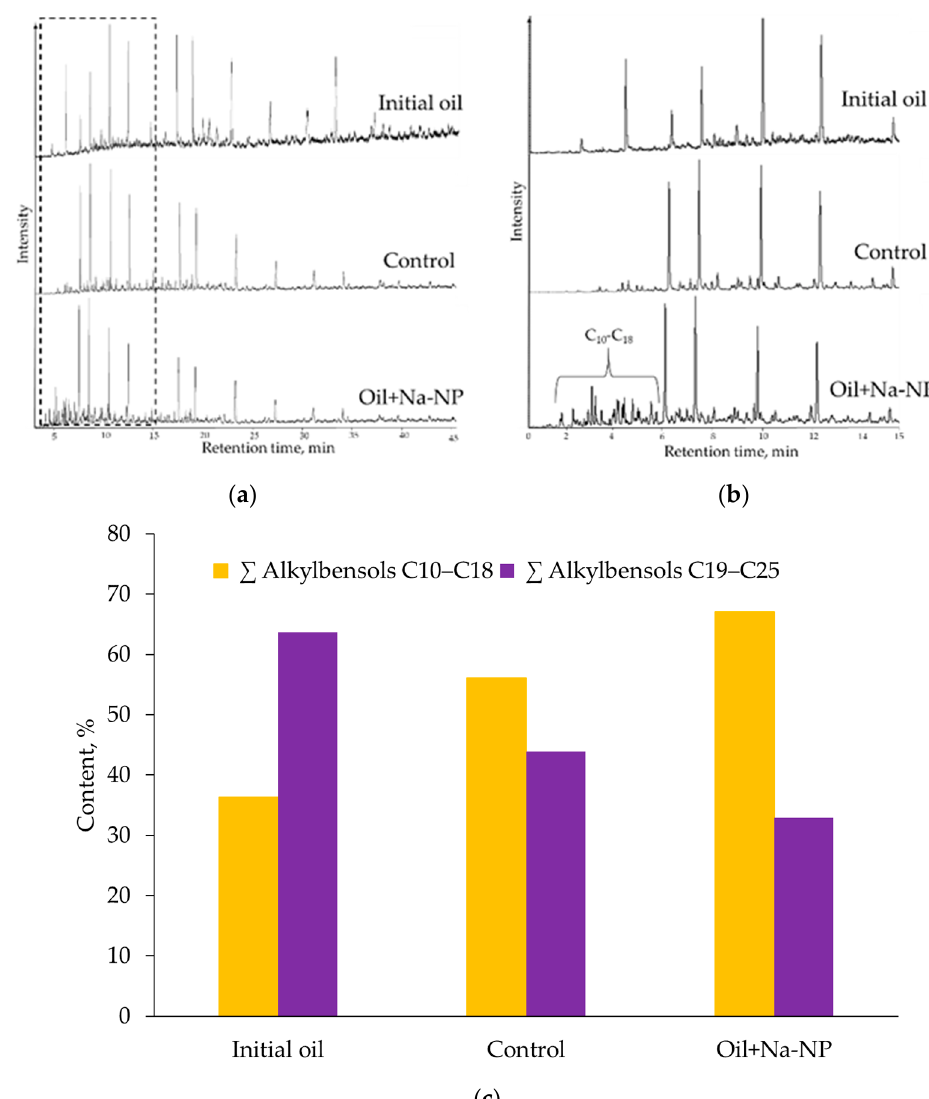
Figure 7. GC-MS spectra of ( a ) aromatics fractions and relative contents of alkylbenzenes ( b , c ) before and after processing.